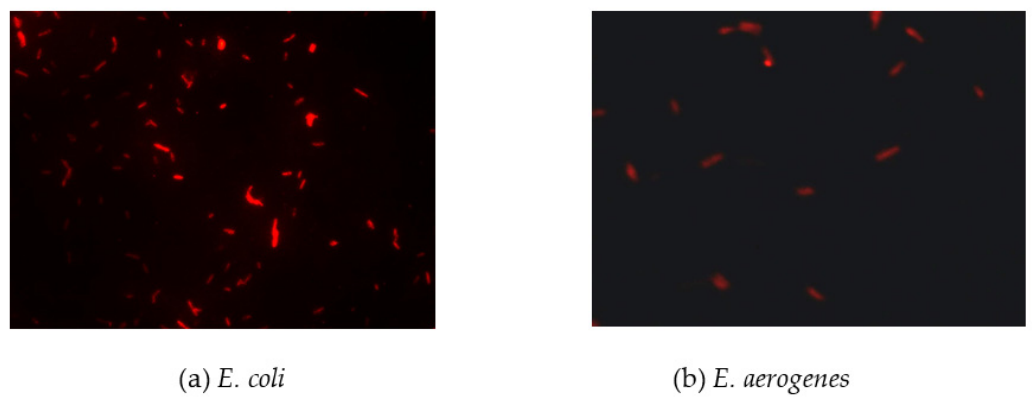
Figure 6. Detection of coliform bacteria in domestic wastewater using FISH .